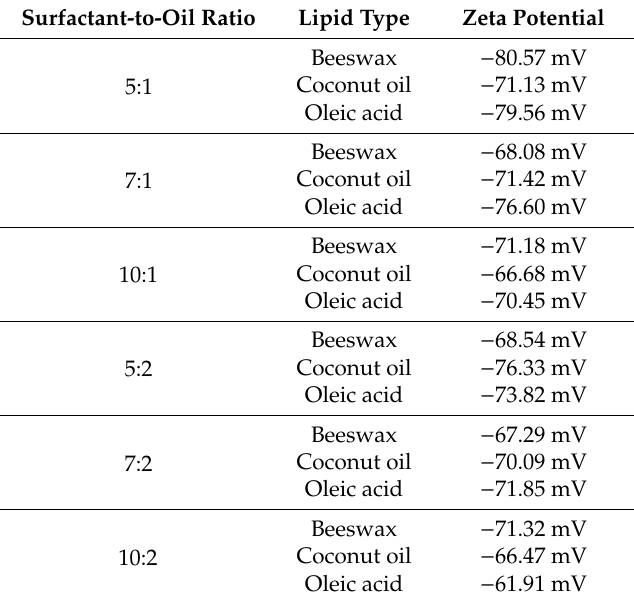
Table 2. Zeta potential of lidocaine